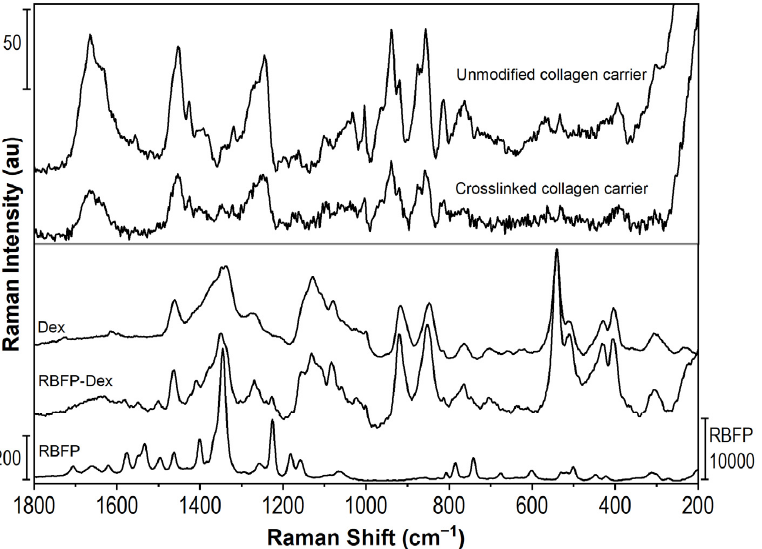
Figure 4. Raman spectra of swollen collagen carrier (unmodified and crosslinked) and dextran (Dex), riboflavin phosphate (RBFP) and the solution of RBFP in Dex.